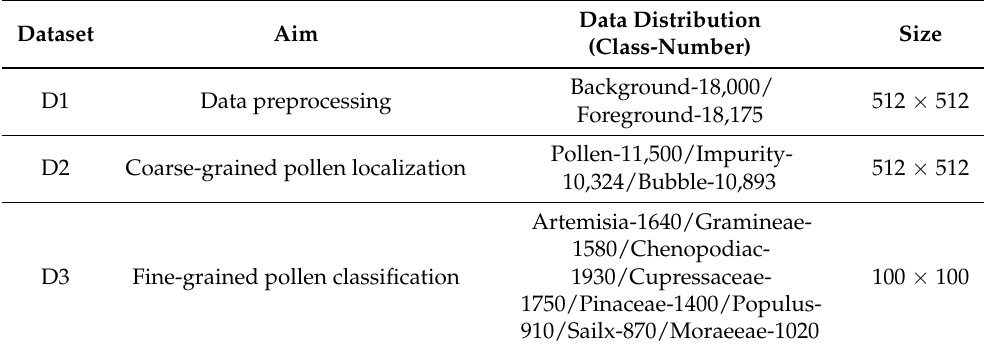
Table 2. The detailed description of three sub-datasets for training and testing our proposed model.